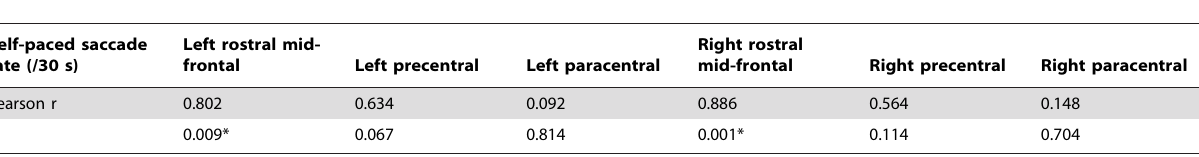
Table 6. Correlations of self-paced saccade rate with frontal areas containing DLPFC, FEF and SEF.